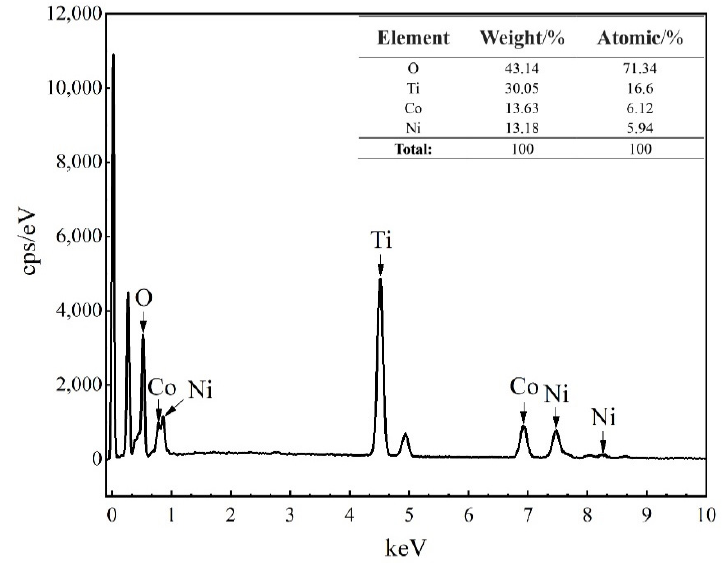
Figure 5. EDS spectrum of products calcined at 800 °C with a Co/Ni ratio of 0.5:0.5 (the analyzed area corresponds to the red box marked in Figure 4(c2)).